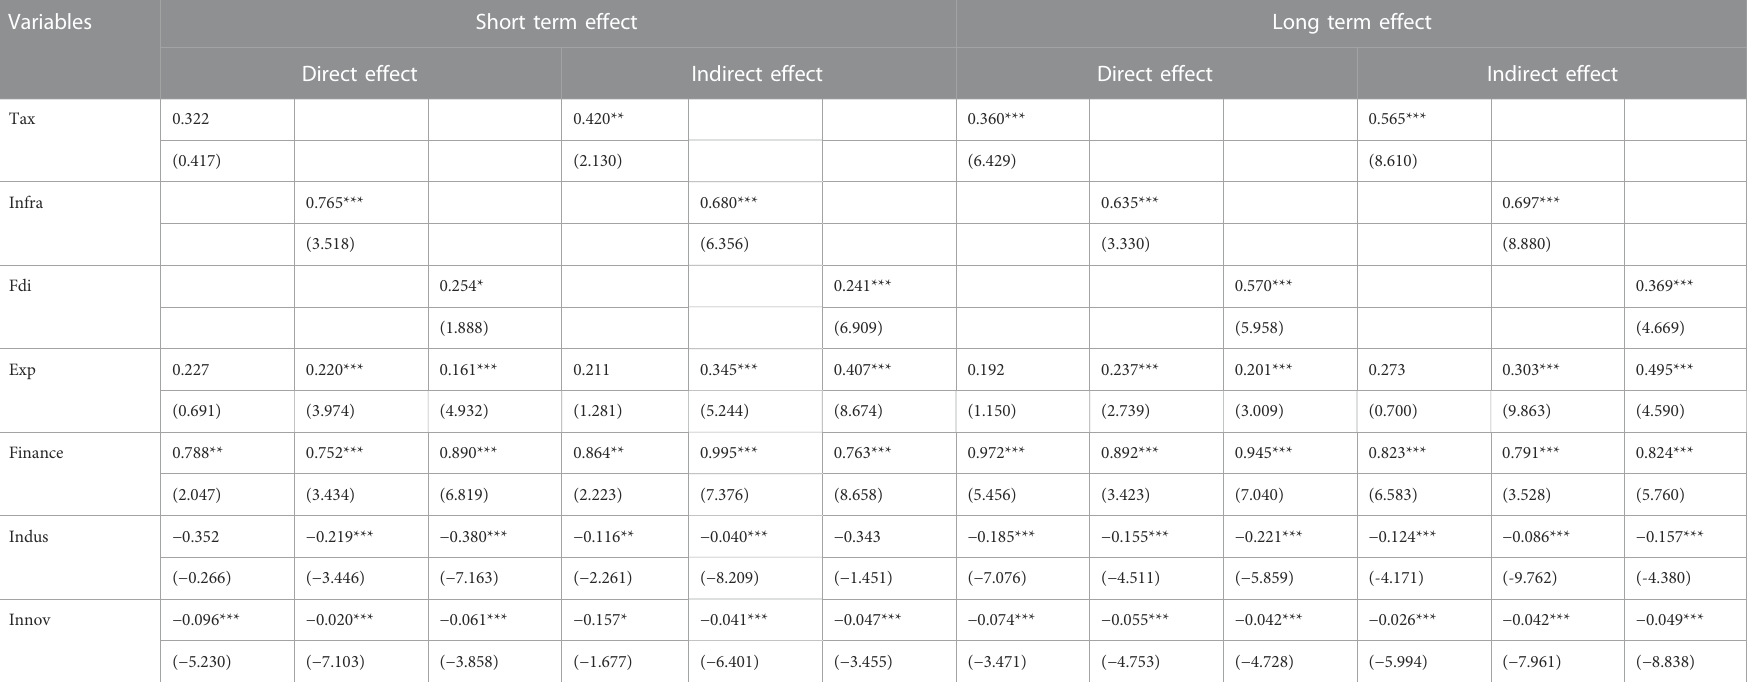
TABLE 6 Spatial spillover effect under W 1 ij matrix as the explained variable is